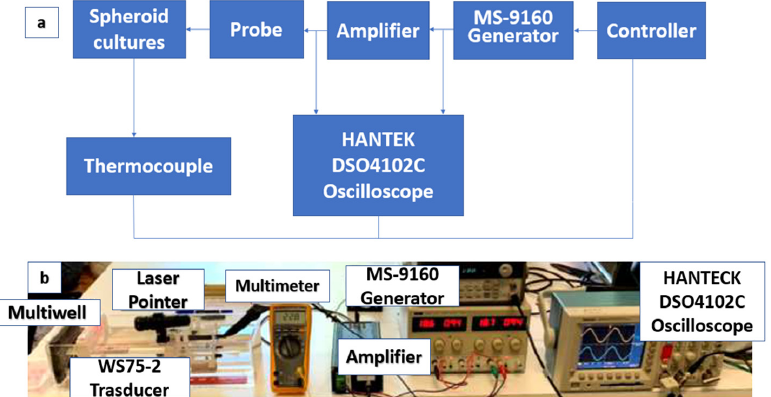
Figure 1. ( a ) Block scheme with connections of the instruments used for the experimental set up. The spheroid cultures are stimulated by the ultrasonic probe (WS75-2 Transducer) which is connected to a generator of sinusoidal functions (MS-9160 Generator). Between the probe and the generator is located the amplifier, designed for the purpose of amplifying the signal in this specific application. The oscilloscope is connected before and after the amplifier to verify that the signal is amplified correctly. The controller block indicates a carry out on the output voltage from the generator to protect the instrumentation from malfunctions. The thermocouple has the function of controlling the rise in temperature, both to check that it does not rise excessively, inducing death by hyperthermia in the spheroid’s cultures, and to check the presence of ultrasound. ( b ) In the picture it is shown how the experimental set up is presented during the experimentation. The spheroid cultures are located in the multiwell and the presence of the laser pointer is aimed at centering with the probe the spheroid designated to be stimulated. The plexiglass structure that supports the probe provides a guide to move it at different focal distances. The multimeter acts as a thermocouple.